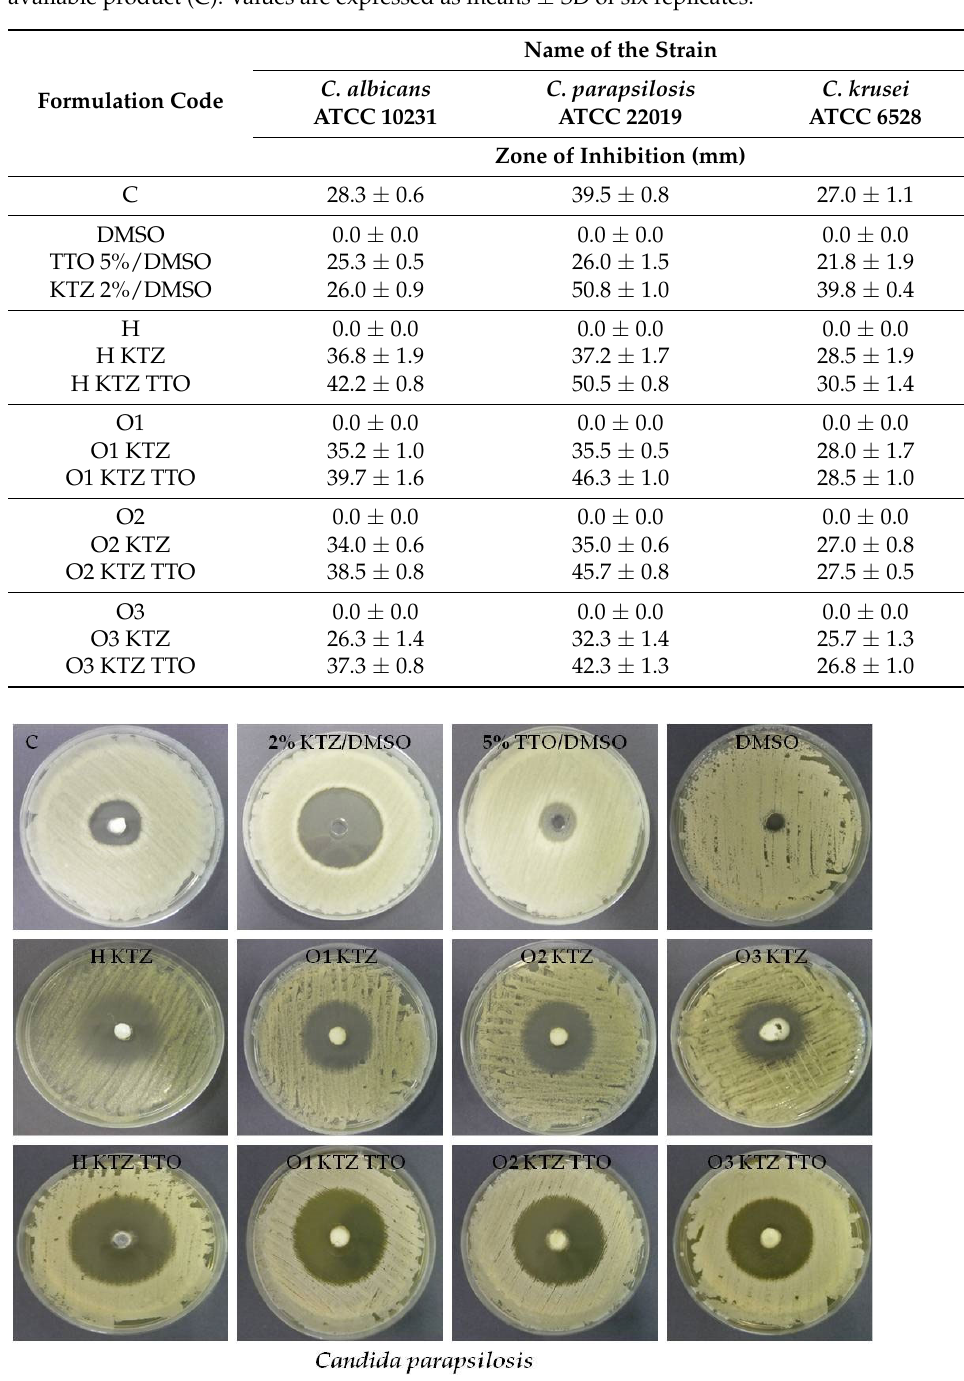
Figure 5. Antifungal activity against C. parapsilosis of prepared PLU ® F ‐ 127 hydrogels and PLO or ‐ ganogels containing KTZ (H KTZ, O1 KTZ, O2 KTZ, O3 KTZ), KTZ and TTO (H KTZ TTO, O1 KTZ TTO, O2 KTZ TTO, O3 KTZ TTO), and controls: DMSO (dimethyl sulfoxide), KTZ 2% in DMSO, TTO 5% in DMSO, and commercially available product